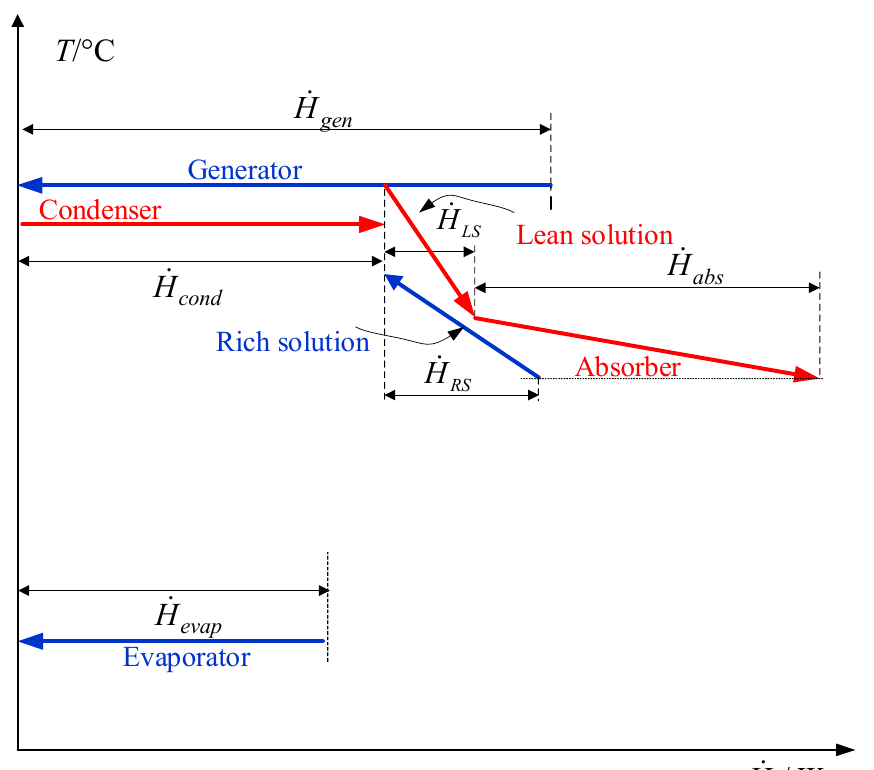
Figure 7. Overall graphical presentation of the AC.